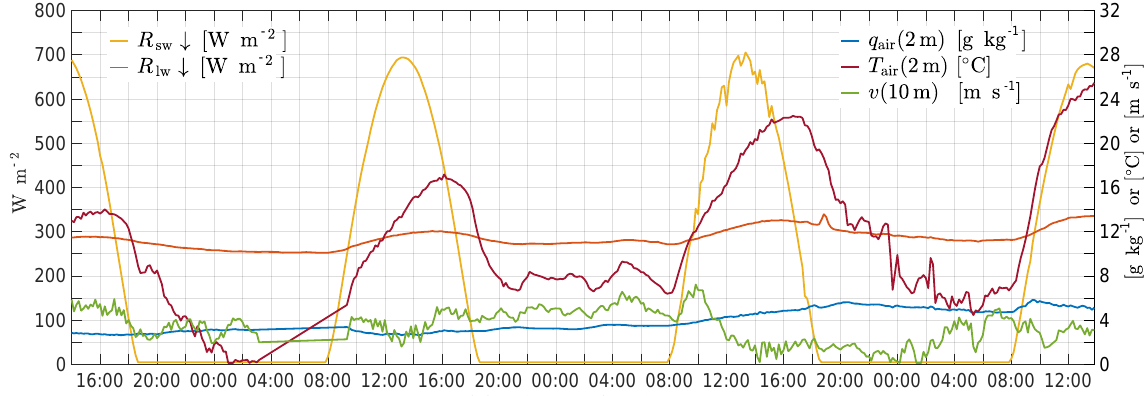
Figure 1. DICE forcing data used for the offline single site experiment in the form of longwave downward radiation ( R lw ↓ , orange) and shortwave downward radiation ( R sw ↓ , yellow) in Wm − 2 (see left axis), as well as the 10m wind speed ( v , ms − 1 , green), the 2m air temperature ( T air , ◦ C, red), and the 2m specific humidity ( q air , gkg − 1 , blue) (see right axis). Data are from the CASES-99 experiment in Kansas from 23 to 26 October